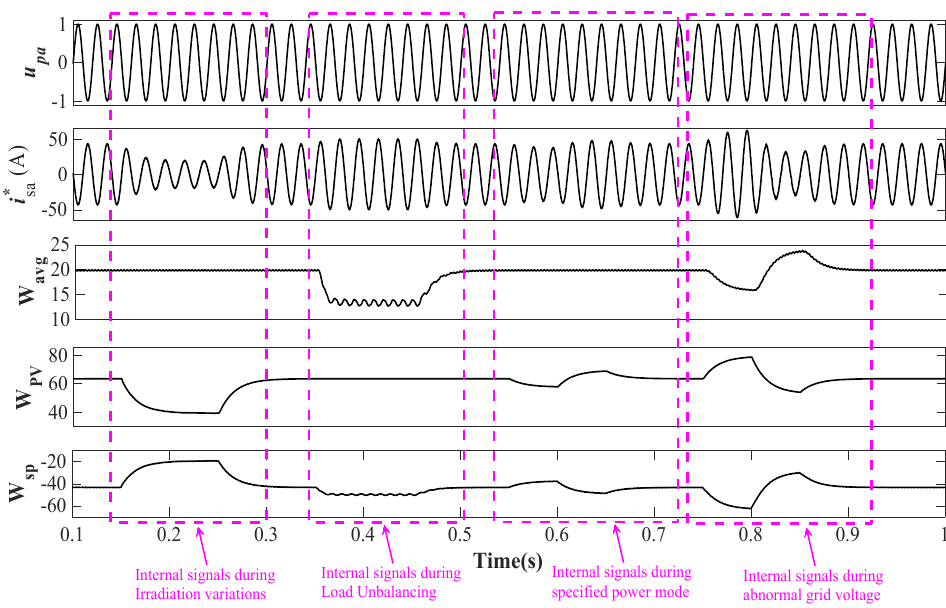
Figure 15. Internal control signal analysis of 𝜇 (cid:3043)(cid:3028) , 𝑖 (cid:3020)(cid:3028)∗ , W (cid:2911)(cid:2932)(cid:2917) , W (cid:2900)(cid:2906) , and W (cid:2929)(cid:2926) .